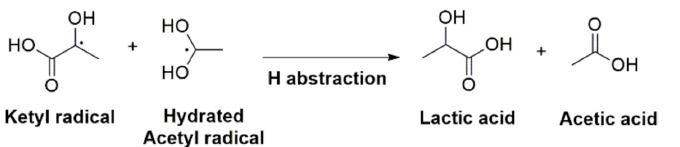
Scheme 10. Proposed formation of lactic acid and acetic acid during PA photolysis in water from Griffith et al.